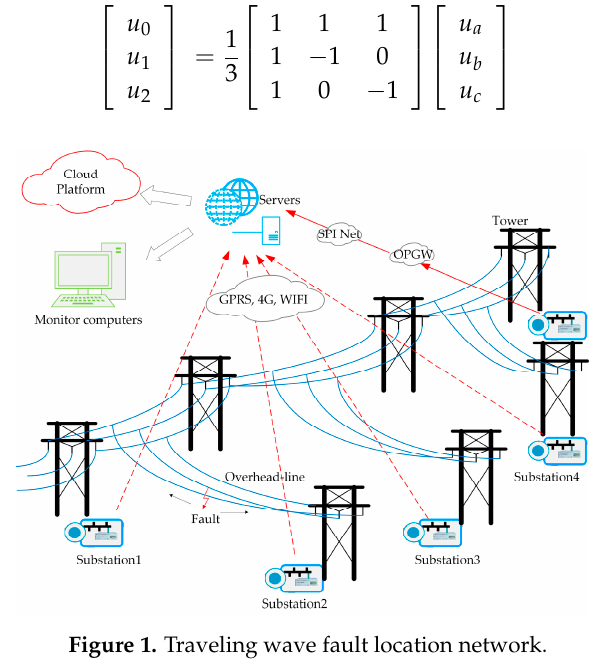
Figure 1. Traveling wave fault location network.